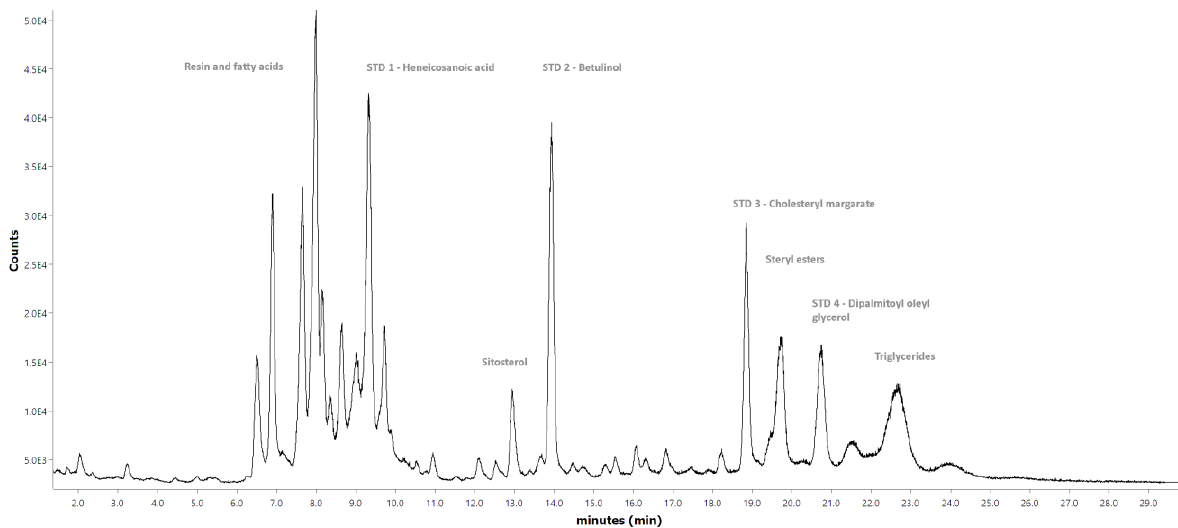
Figure A3. Reference gas chromatography with flame ionisation detection (GC-FID; short-column) chromatogram for hexane extract of spruce bark.